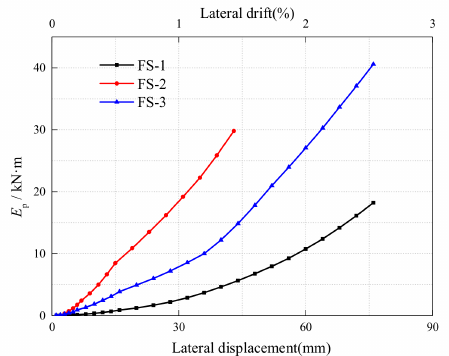
Figure 13. Cumulative energy dissipation curves.